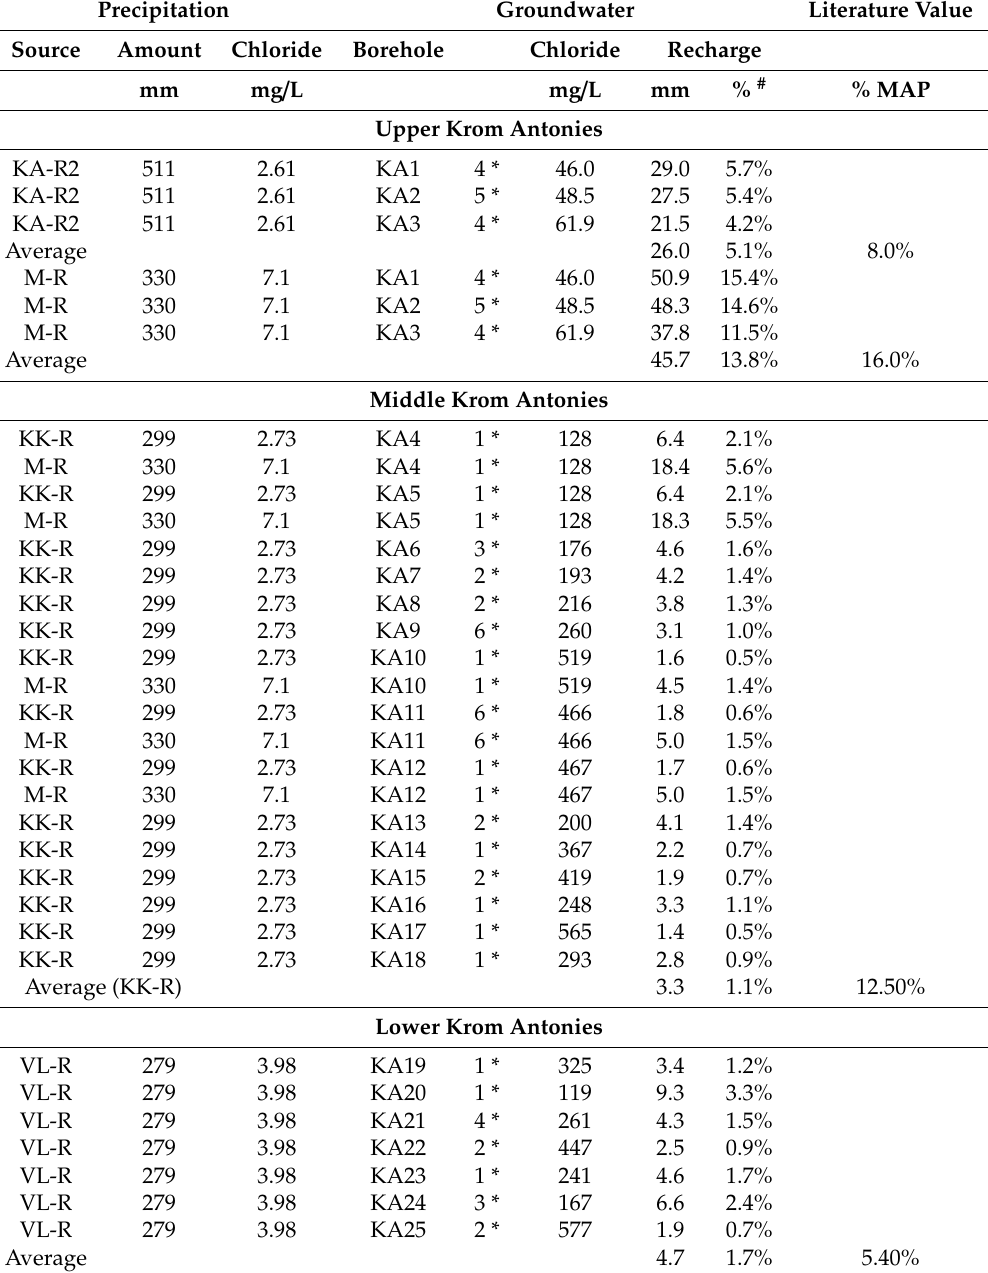
Table 3. Results of CMB calculations for the Krom Antonies, with separations in upper, middle and lower sections based on di ff erent values of groundwater and precipitation chloride values. Literature values in last column from